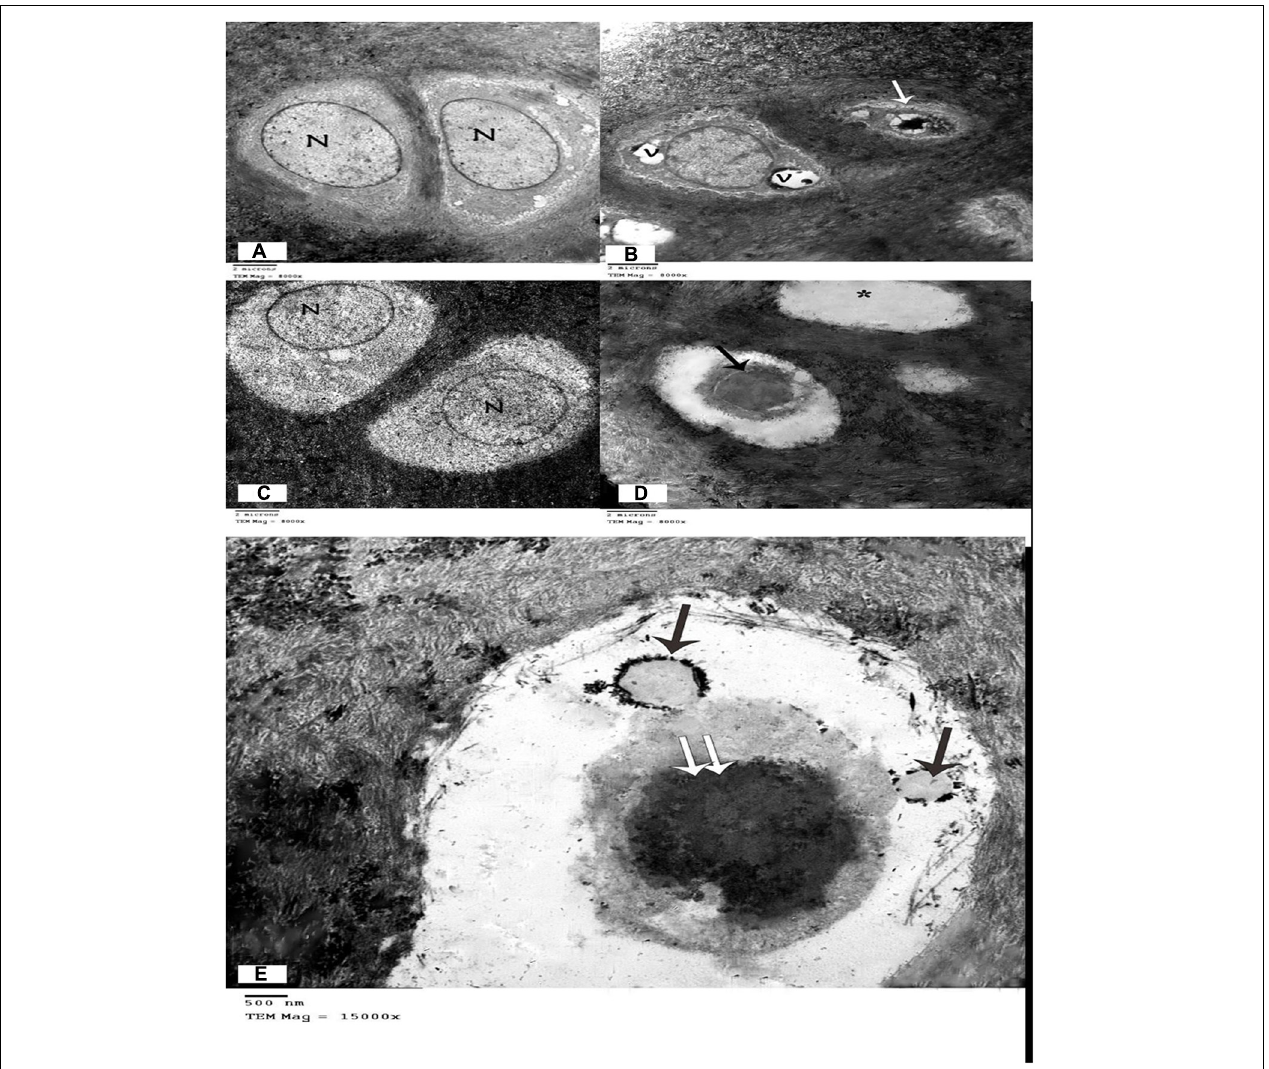
FIGURE 4 | (A) Electron micrograph showing two chondrocyte with lacunae. Vesicular nuclei (N), and cytoplasm with few organelles are evident. Chondrocytes are surrounded by a matrix full of collagen fibrils. (Control group, TEM, × 8000). (B) Electron micrograph of the arthritic group showing one chondrocyte with large vacuoles in the cytoplasm and another chondrocyte that appears shrunken with irregular contours, scanty cytoplasm, and a dark, irregular nucleus. (Arthritis group, TEM, × 8000). (C) Electron micrograph showing two chondrocytes within lacunae with vesicular nuclei and normal cytoplasm. (Group treated with methanolic extract of the fungus, TEM, × 8000). (D) Electron micrograph of the group treated with an ethyl acetate extract of the fungus, showing one shrunken chondrocyte with dark nucleus ( ↑ ), and empty lacuna ( ∗ ). (Methanolic extract of the fungus group, TEM, × 8000). (E) Electron micrograph of the group treated with a methanolic extract of the fungus, showing apoptotic bodies ( ↑ ) in a shrunken chondrocyte with dark nucleus ( ↑↑ ). (Methanolic extract of the fungus group, TEM, ×